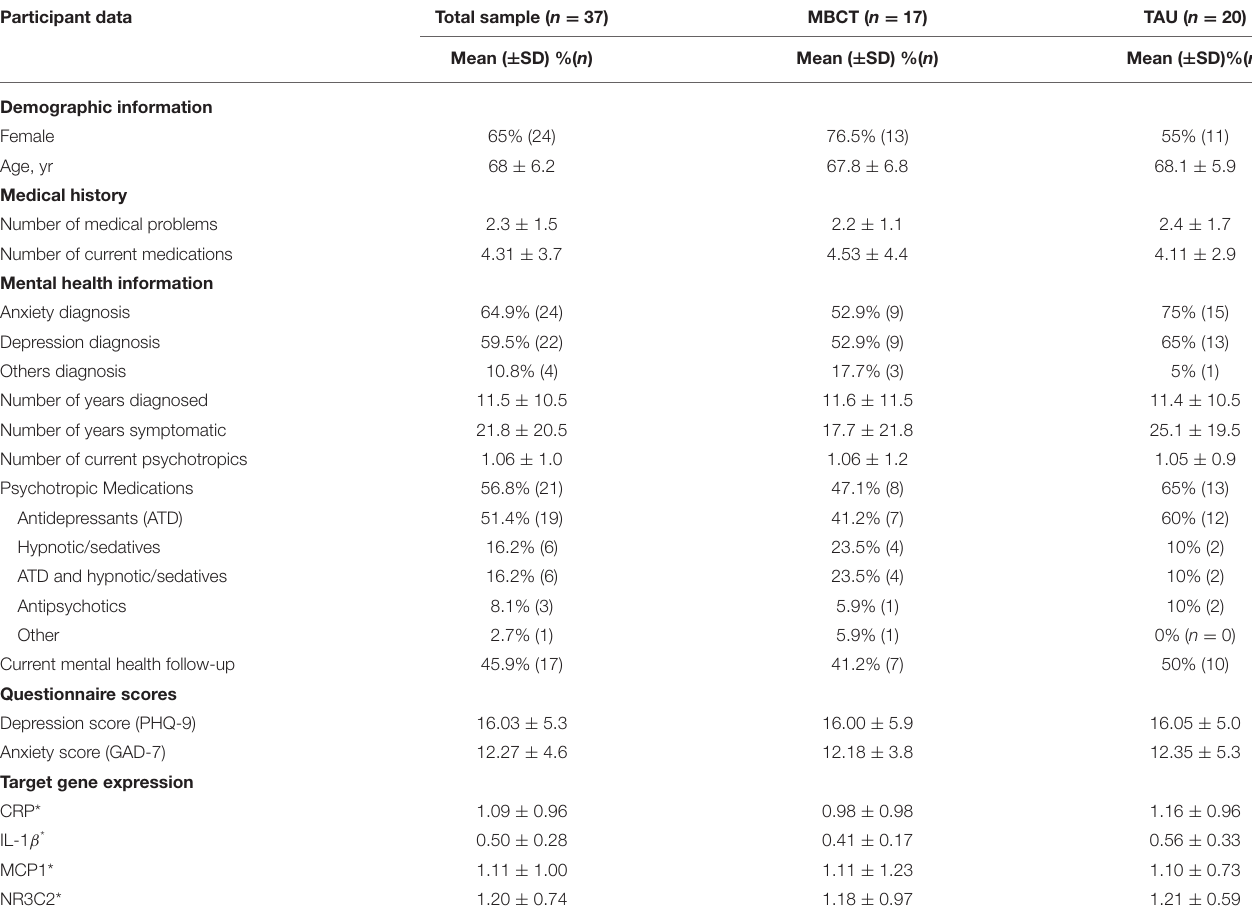
TABLE 1 | Baseline demographics, clinical and target gene expression data. Participant data